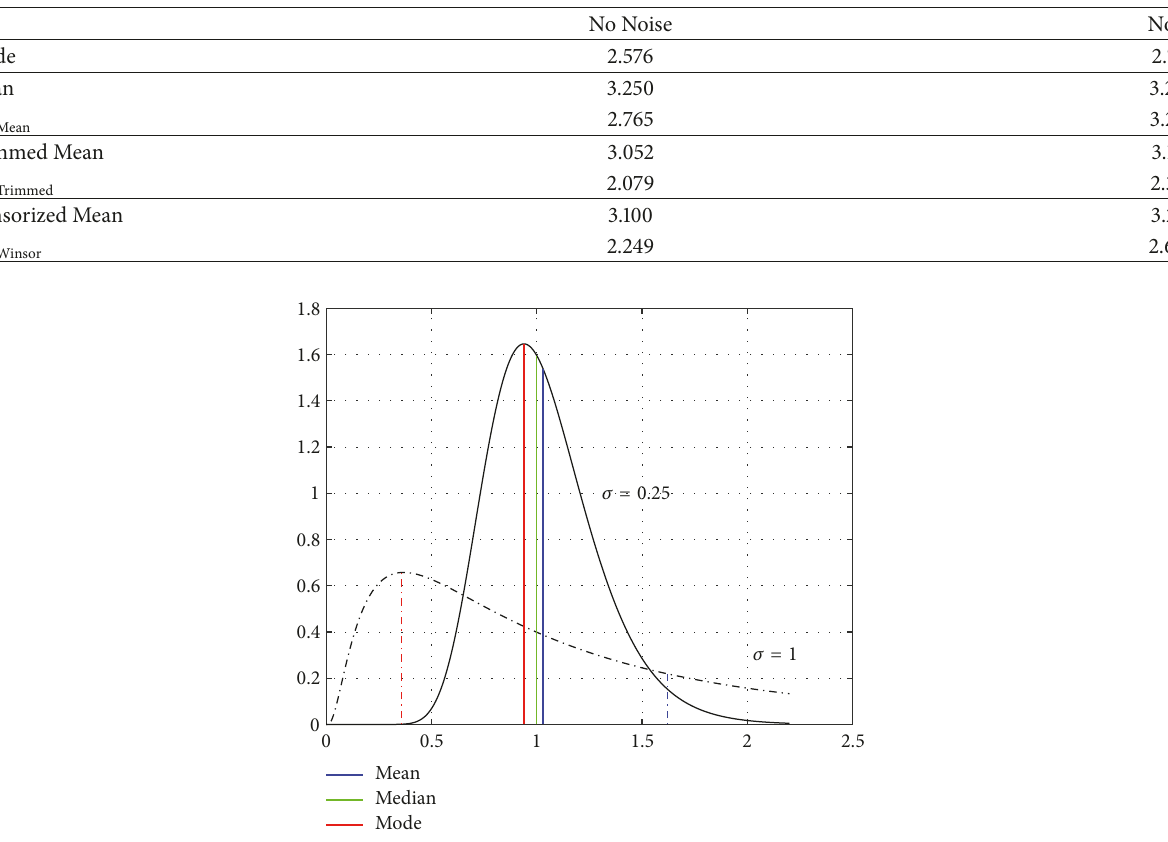
Figure 3: Log normal pdf. Comparison of mean, median, and mode of two log-normal distributions with different